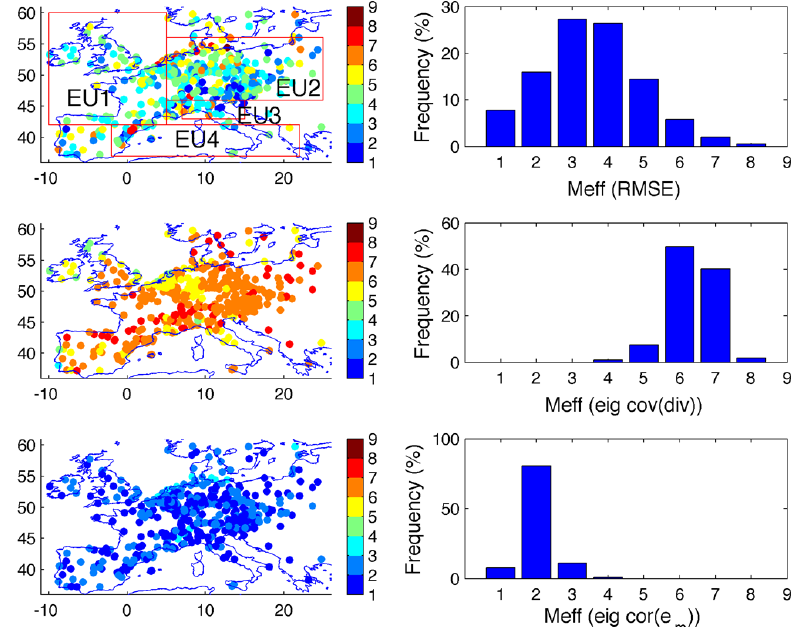
Figure 9. Top: spatial distribution of M eff based on minimum error combination (left) and its histogram (right). Middle: same as top but for M eff based on the eigenvalues of the covariance of the diversity matrix. Bottom: same as top but for M eff based on the eigenvalues of the cor(ei,ej) matrix. Please note the different range of the y -axis between the different